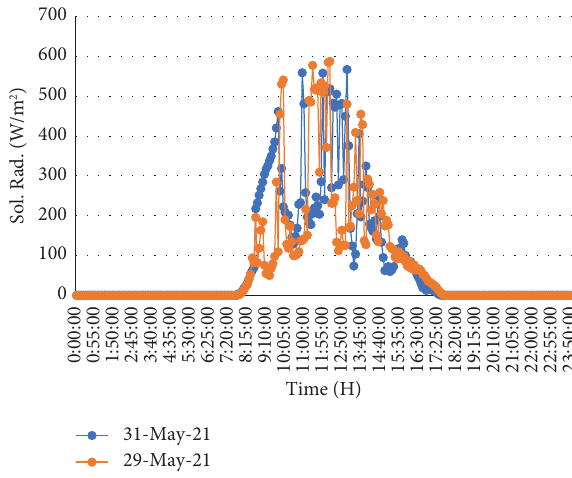
Figure 6: Solar radiation curves under low average daily solar radiation.